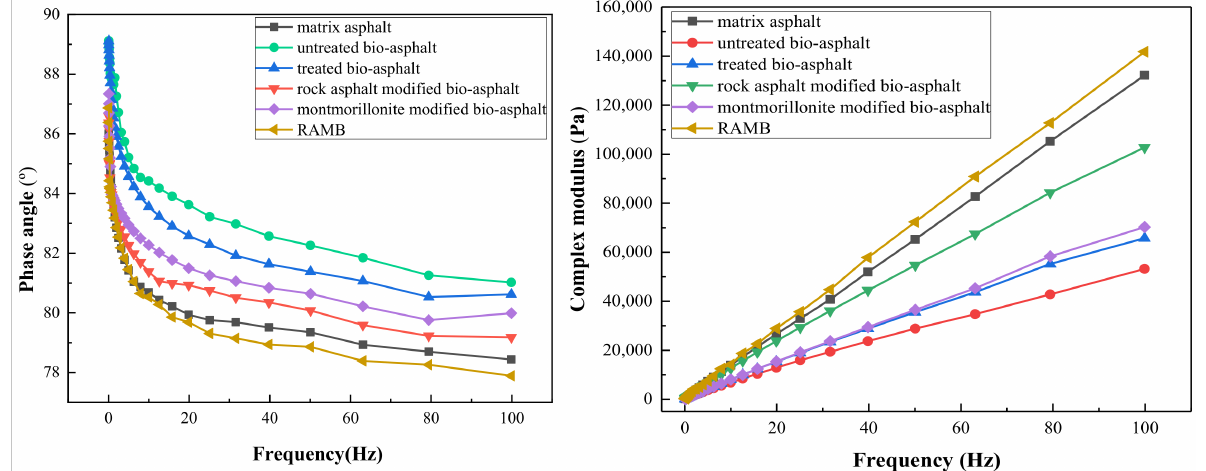
Figure 5. Graph of the G* and δ values of six asphalts at 58 ◦